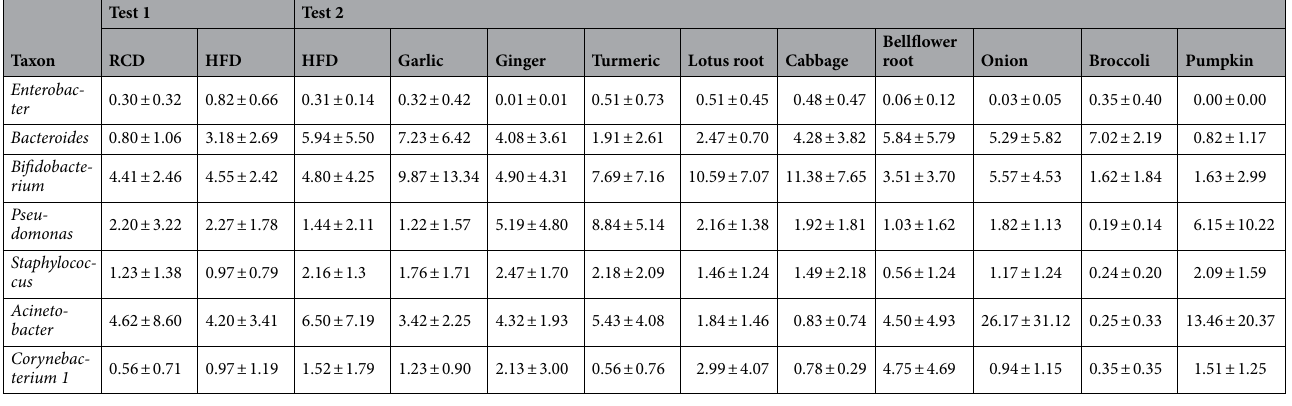
Table 1. Significant alteration of relative abundance in mouse serum microbiome composition of genera in clinical tests after dietary intervention. Test 1: regular chow diet (RCD) vs. high fat diet (HFD), Test 2: HFD vs. HFD + diet.